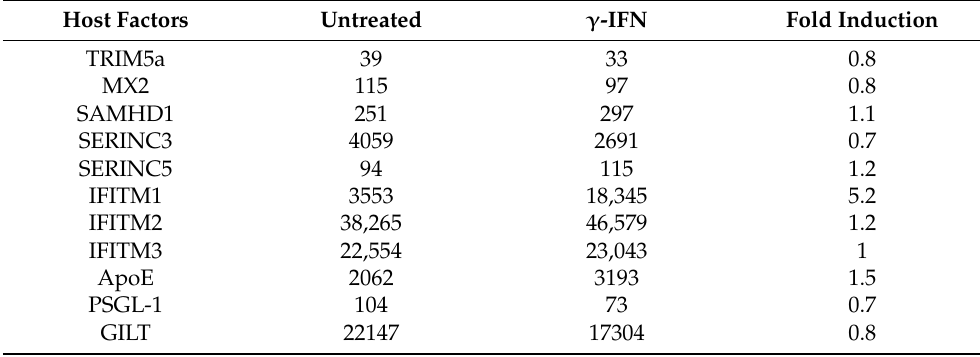
Table 1. Induction of already known restriction factors by γ